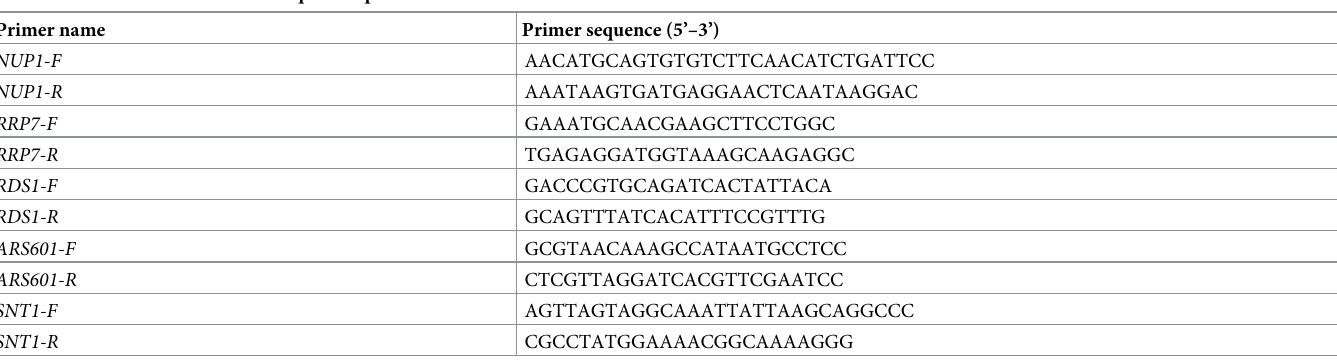
Table 3. Primers used for the ChIP-qPCR experiments.